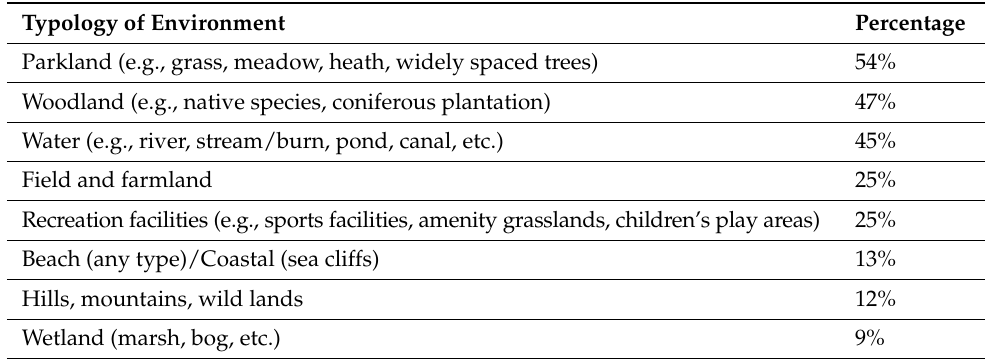
Table 2. Typology of natural environment regularly visited by the